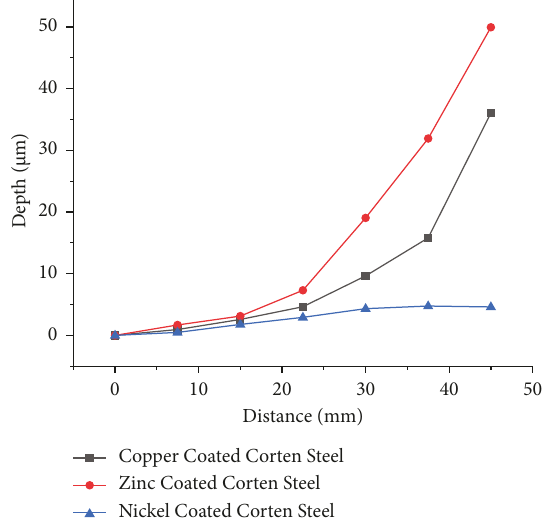
Figure 5: Scratch penetration depth of electroplated corten